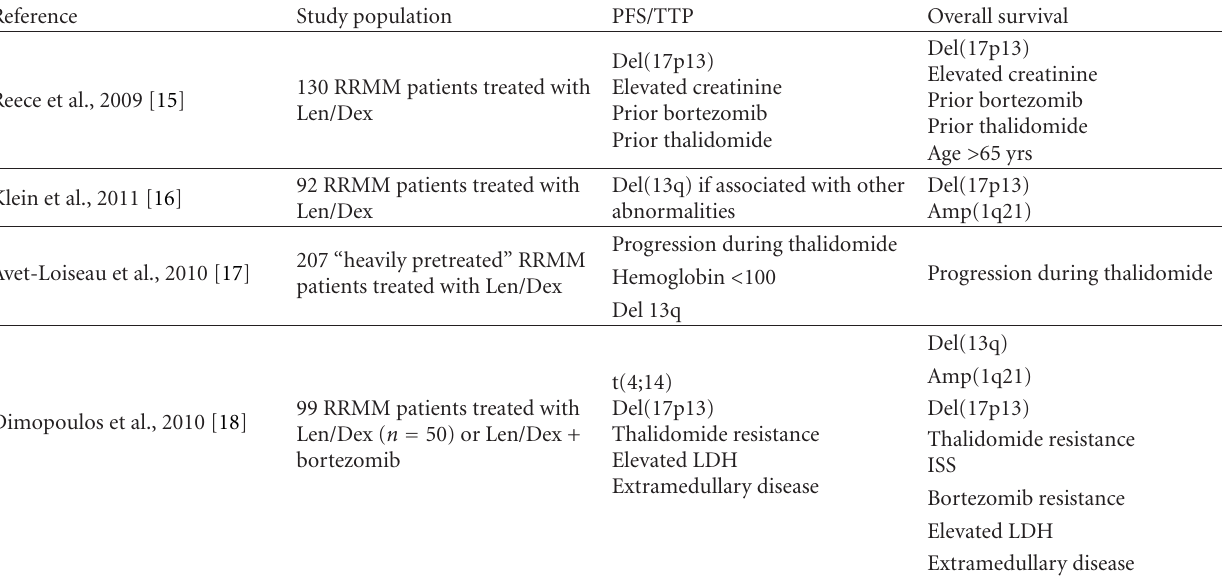
Table 5: Adverse prognostic factors identified by multivariate analysis in patients with relapsed/refractory myeloma treated with lenalidomide and dexamethasone.